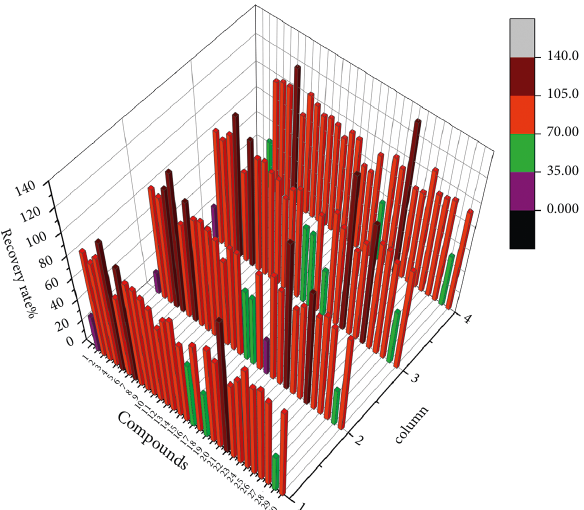
Figure 3: PCX, SCX, X-C, C18/SCX SPE cartridges for the recovery of PAs. X -axis: 1 . Em, 2 . Er, 3 . Eu, 4 . He, 5 . Ic, 6 . Im, 7 . Jb, 8 . Lc, 9 . Mc, 10 . Re, 11 . Sk, 12 . Sn, 13 . Sp, 14 . Sv, 15 . Td, 16 .7-Ly, 17 .7-Im, 18 . EmNO, 19 . ErNO, 20 . EuNO, 21 . HeNO, 22 . IcNO, 23 . JbNO, 24 . LcNO, 25 . LyNO, 26 . McNO, 27 . ReNO, 28 . SnNO, 29 . SpNO, 30 . SvNO. Y -axis: 1 . PCX, 2 . SCX, 3 . X-C, 4 . C18/SCX. For the abbreviations of the compounds, see Section 2.1